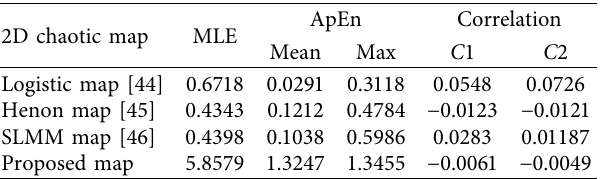
Table 1: Dynamical features comparison of different 2D discrete chaotic maps. 2D chaotic map MLE